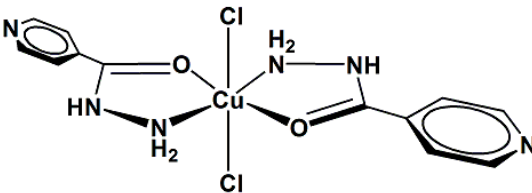
Figure 2. Proposed structure for the [CuCl 2 (INH) 2 ]·H 2 O complex ( 1 ).